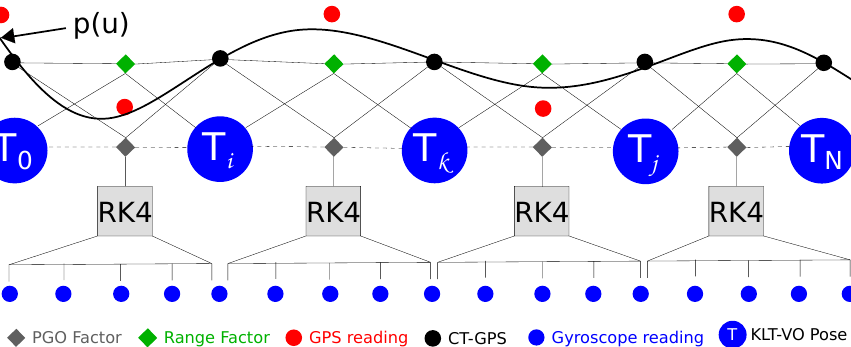
Figure 4. Initialization factor graph. p ( u ) is the CT-GPS trajectory generated at high frequency. RK4 is the Runge–Kutta 4th order gyroscope integration scheme. Dotted lines denote the error term ( ˆ T in Equation (7) between any two KLT-VO